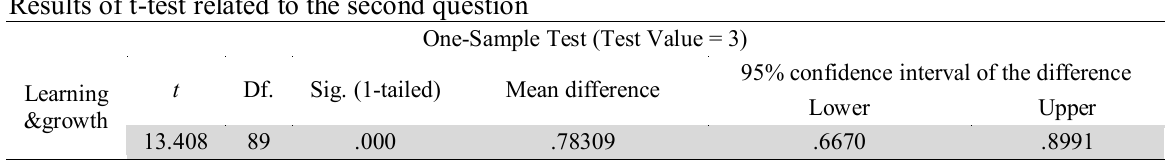
Results of t-test related to the second question